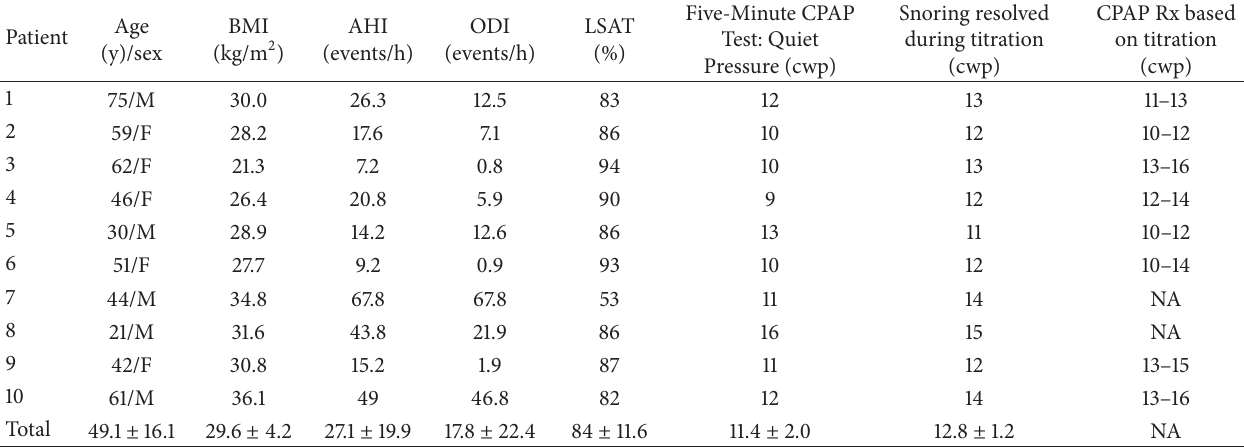
Table 2: Quiet Pressures from the Five-Minute CPAP Test, snoring during titration study, and CPAP titration-based prescription (prescriber was blinded). % = percent; AHI = apnea-hypopnea index; BMI = body mass index (in kilograms per meter 2 ); cwp = centimeters of water pressure; LSAT = lowest oxygen saturation; NA = not applicable (two patients started with CPAP and were later converted to bilevel, which